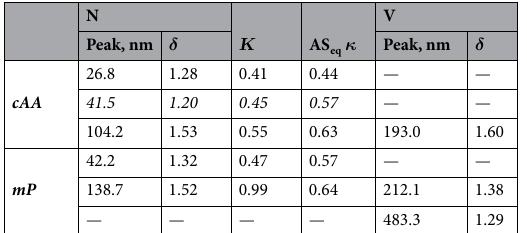
Table 1. Log-normal fit parameters for number and volume size distributions. Particle dry diameter (peak diameter, nm), spread ( δ ), κ , and equivalent κ -value for pure ammonium sulphate at that particle size (AS eq κ ) for fitted number peaks shown on left. Particle volume-size distribution (peak diameter, nm) and spread ( δ ) of the fitted peaks shown on right. Empty spaces indicate that corresponding peaks have an amplitude too small to be fitted reliably. All κ computed assuming a constant surface tension of 0.072 N m − 1